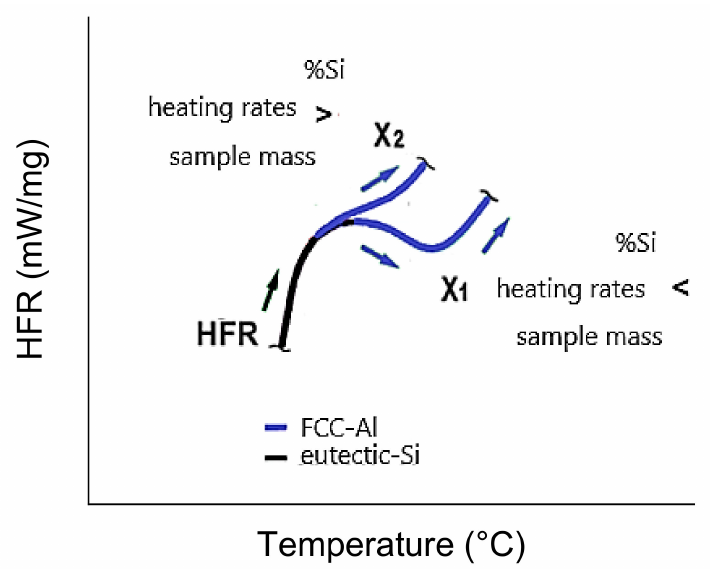
Figure 11. Correlation between Si content, heating rate and DSC sample mass and the feasibility of identifying ∆ T THIXO for the Al-Si-Zn